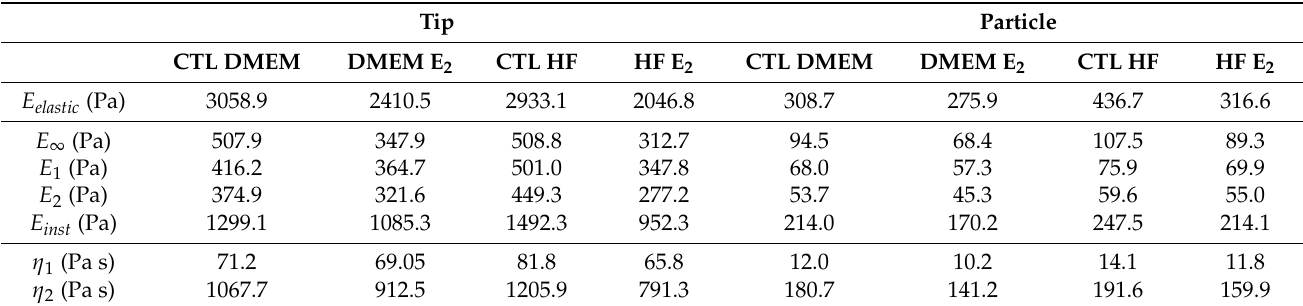
Table 1. Median values of the elastic and viscoelastic properties derived for measurements on MCF-7 cells with either tips or particles (CTL and estrogen-treated).